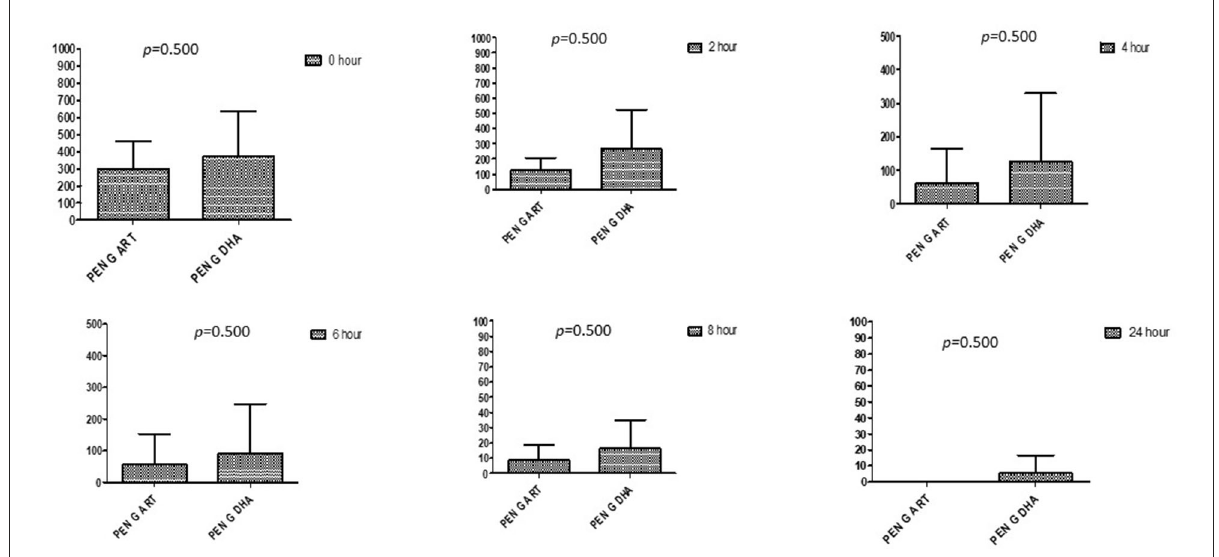
FIGURE5 Comparison of minimum inhibitory concentrations ( µ g/mL) of Penicillin G when combined with ART and DHA on E. coli. PENG ART, Penicillin G combined with ART; PEN G-DHA, Penicillin G combined with DHA; p < 0.05 indicate a significant difference among MICs of antibiotic combined with ART and DHA.